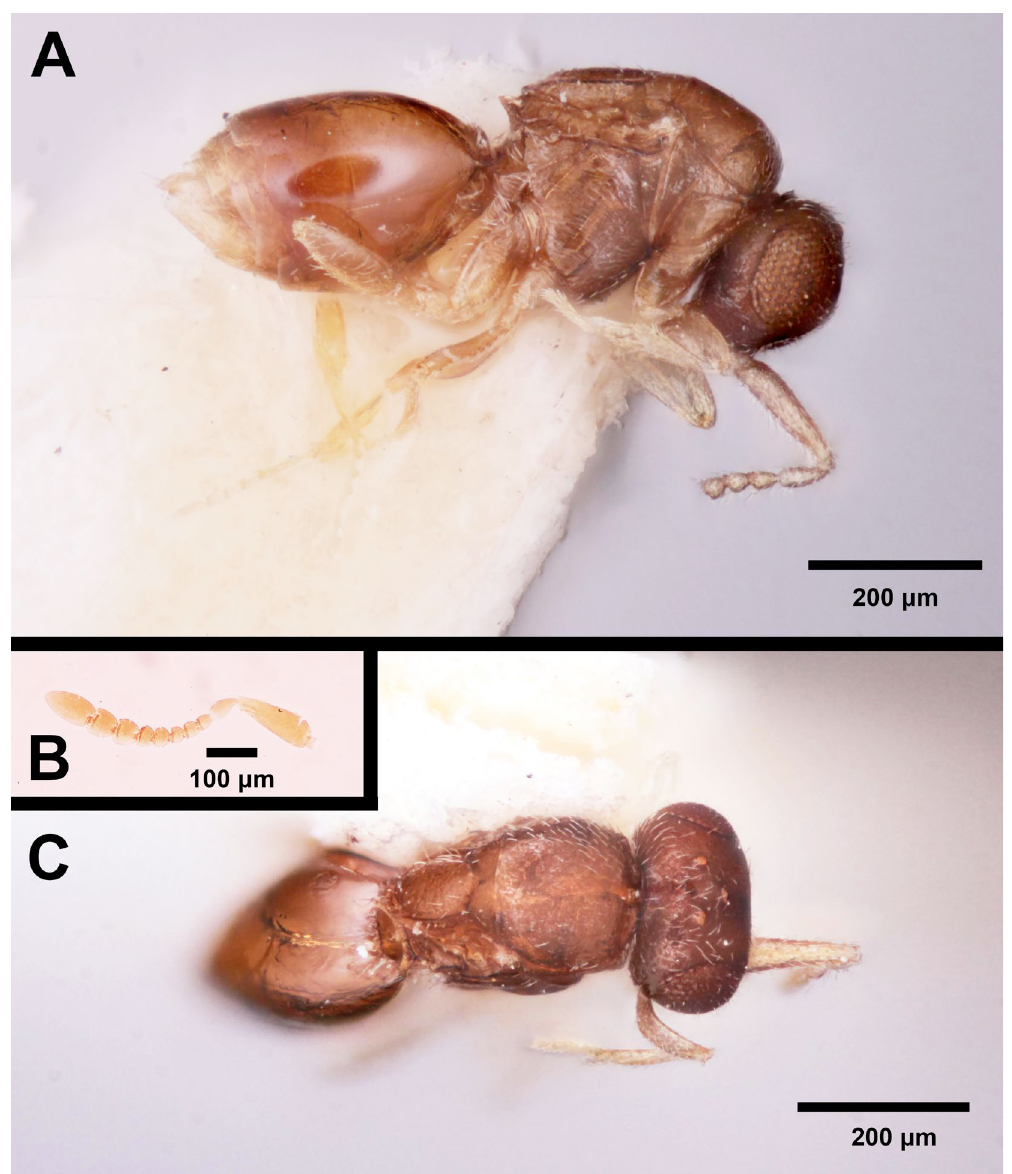
Fig. 8. Aphanogmus radialis kieffer, 1907, holotype, ♀. A . Lateral view (MNhN EY25347). B . Left antenna (MNhN EY22467). C . Dorsal view (MNhN